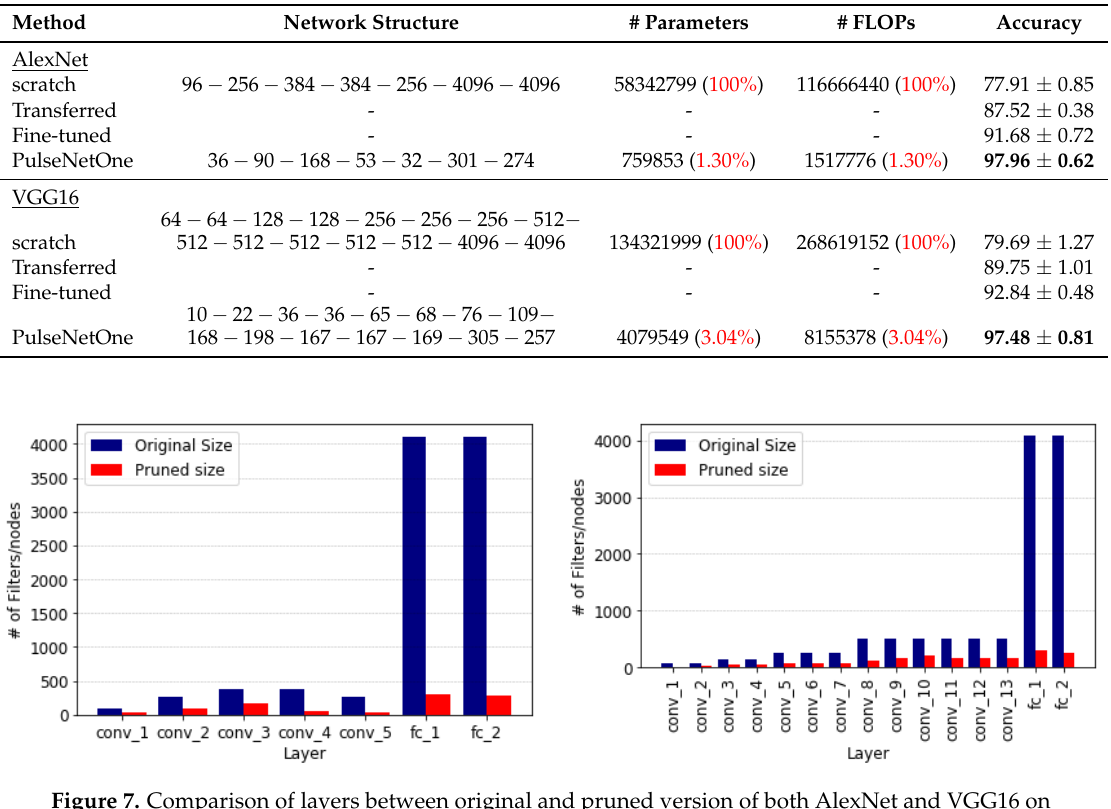
Figure 7. Comparison of layers between original and pruned version of both AlexNet and VGG16 on the Scene15 dataset.